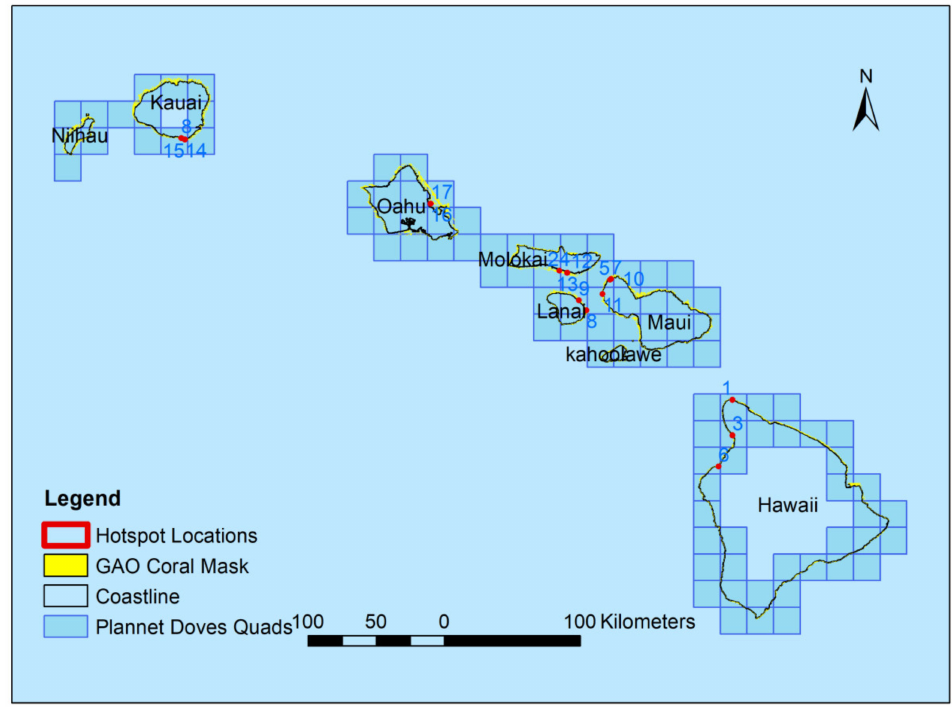
Figure 3. Coverage of the Planet Dove satellite data and the coral bleaching locations collected from field surveys. Planet Dove quads are shown in dark blue